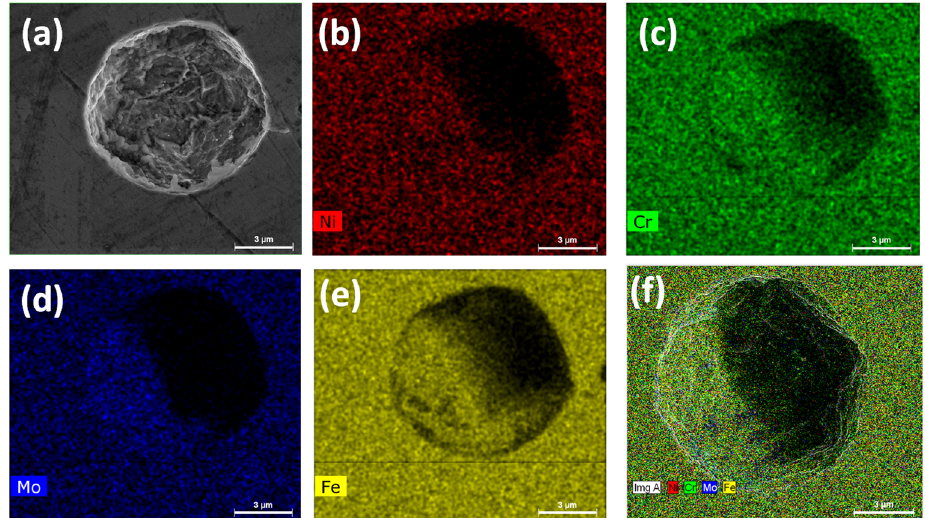
Figure 2. SEM image of ( a ) MMSS after potentiodynamic polarization in 10 g/L NaCl at 20 °C in a saturated CO 2 environment (pH~5), showing a pit formation and the corresponding EDX elemental mapping of ( b ) Ni, ( c ) Cr, ( d ) Mo, ( e ) Fe and ( f ) Ni, Cr, Mo, Fe.